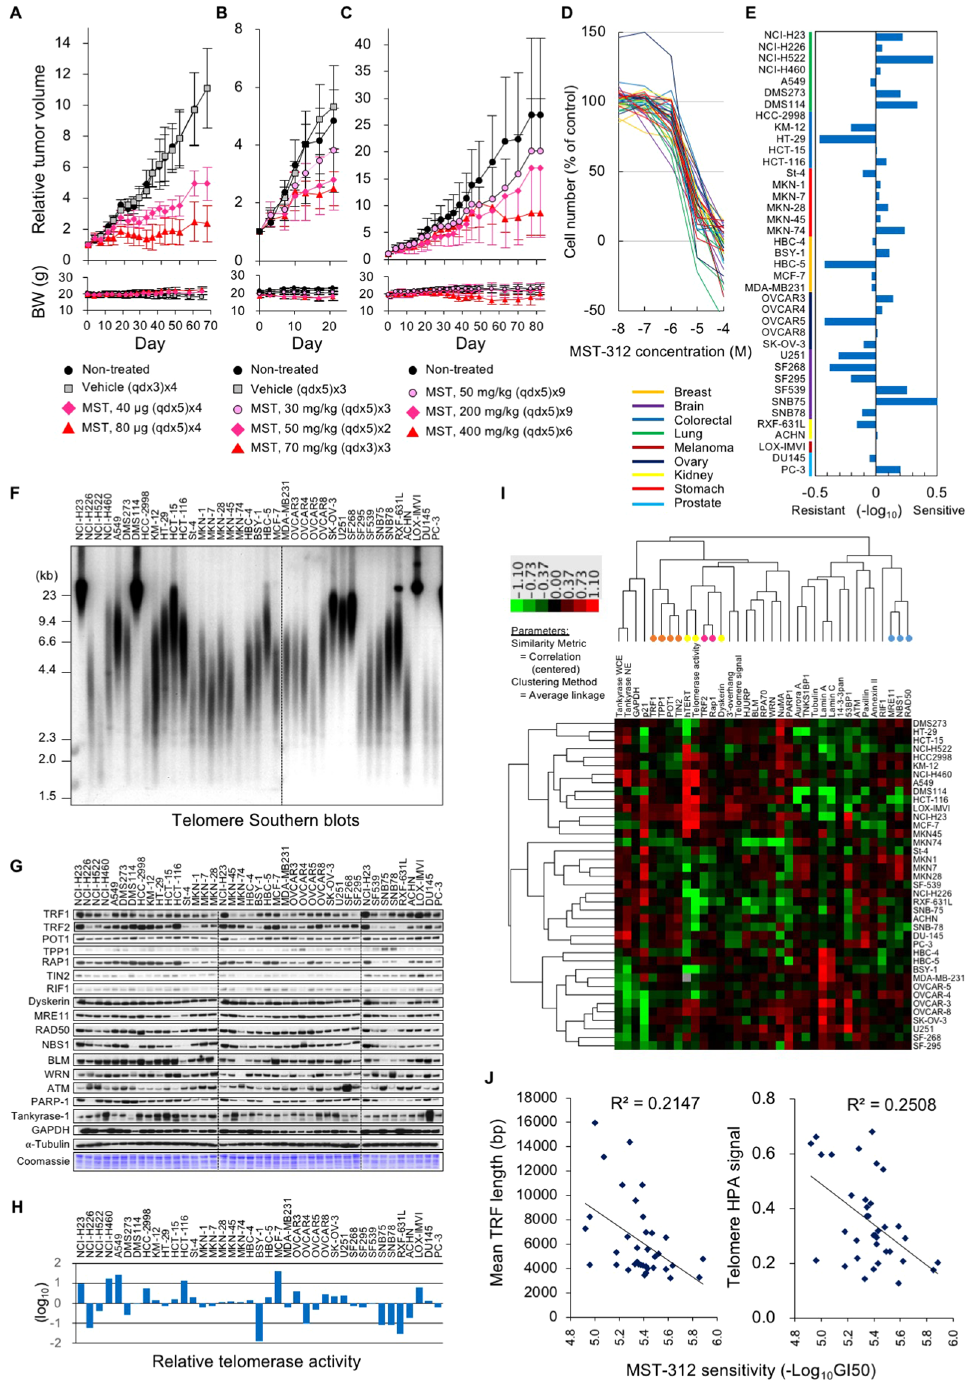
Figure 1. Acute anticancer effect of MST-312 inversely correlates with telomere length of cancer cells. ( A – C ) In vivo anti-tumour effect of MST-312 in mouse xenograft models. Human breast cancer HBC-4 cells were subcutaneously injected into nude mice. Mice were treated with intratumoural ( A ), intravenous ( B ) or oral administration ( C ) of vehicle or MST-312. Error bar indicates standard deviation. Upper and lower graphs indicate the relative tumour volume and body weight (BW) of the mice, respectively. ( D ) In vitro anti- proliferative effect of MST-312 on the JFCR39 panel of 39 human cancer cell lines. Cells were treated with indicated concentrations (molar) of MST-312 for 48 h and then cell numbers were quantitated. ( E ) Fingerprint of MST-312 sensitivity. GI 50 values of MST-312 quantitated by ( D ) and the average of all cell lines was defined as zero. ( F ) Telomere blot analysis of JFCR39. Genomic DNA was prepared and subjected to Southern blot analysis with the [ 32 P]-labelled telomeric probe to detect telomeric restriction fragments (TRFs). Two different blots were derived from the same experiment and were processed in parallel. Their border was indicated by a dotted line. ( G ) Expression of telomere-related proteins in JFCR39. Cell lysates were prepared and